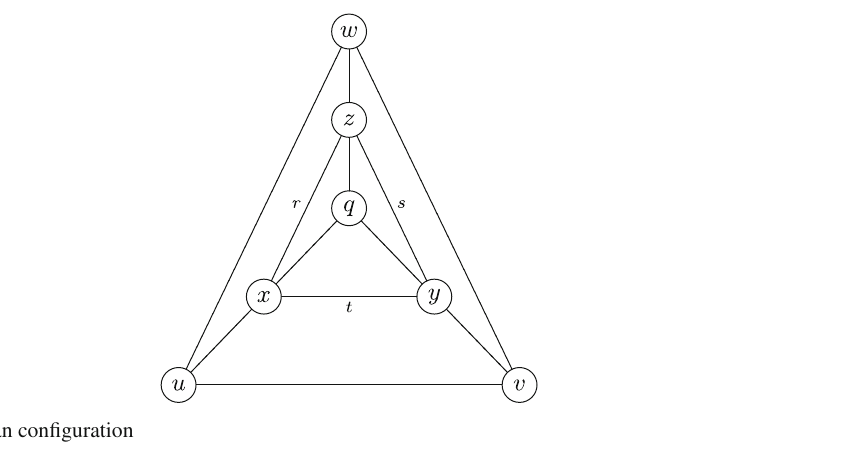
distinct vertices form an edge. In particular, the scheme X is ( q − 1 ) -saturated whenever the rank of X is at least